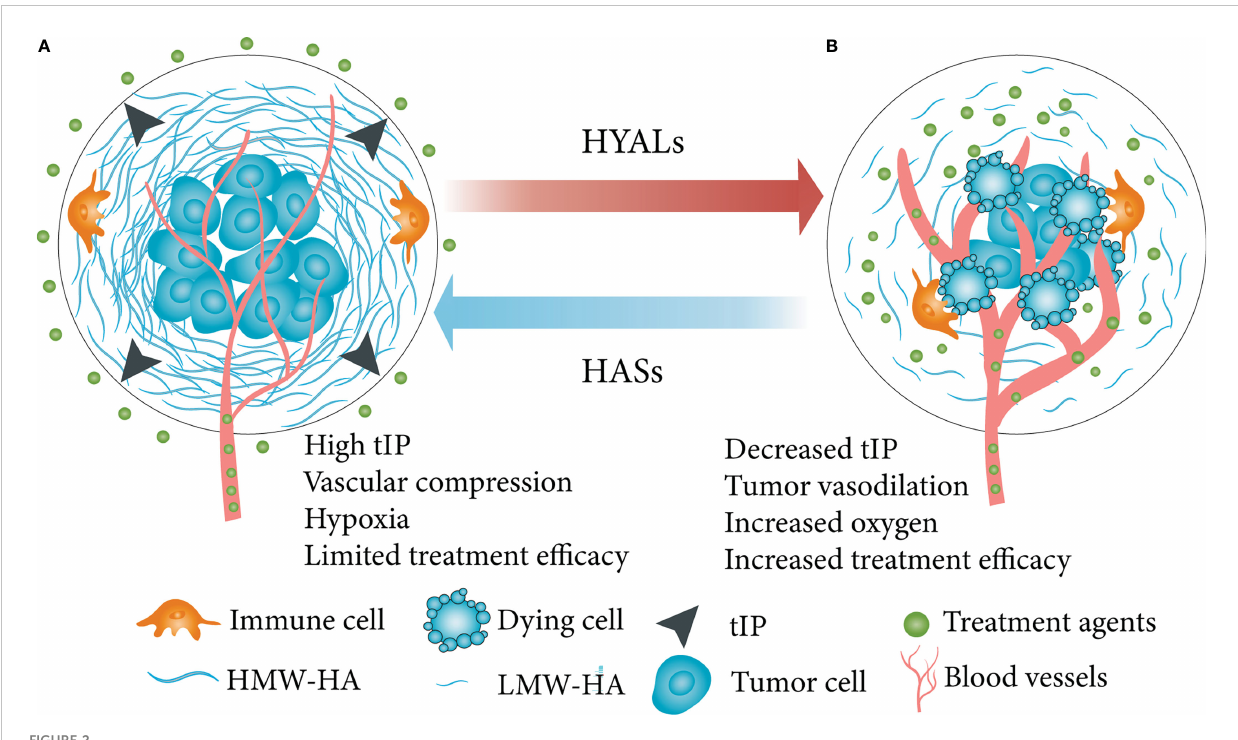
FIGURE 2 Simpli fi ed schematic diagram of HA depletion in a HA-enriched tumor phenotype. (A) HA swelled the TME, increased tIP, compressed tumor vasculature, caused tumor hypoxia and other effects, then limited the effectiveness of therapeutic molecules. (B) HA depletion in tumor led to vascular permeability, improved drug penetration, inhibited tumor growth and improved therapeutic ef fi cacy. HA, hyaluronan; TME, tumor microenvironment; tIP, tumor interstitial pressure; HYALs, hyaluronidases. Figure adapted from Ref